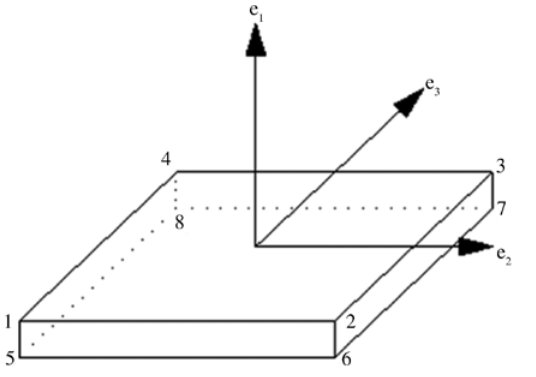
Figure 8: Interface element model.